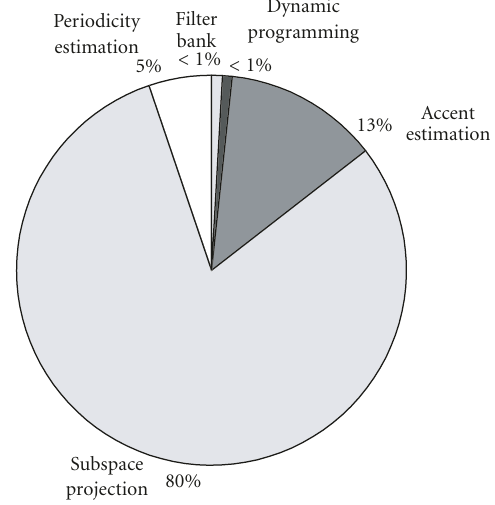
Figure 16: Computational cost of the tempo estimation system. The total processing time required for analyzing a 20-second mu- sical excerpt time is 23 . 248